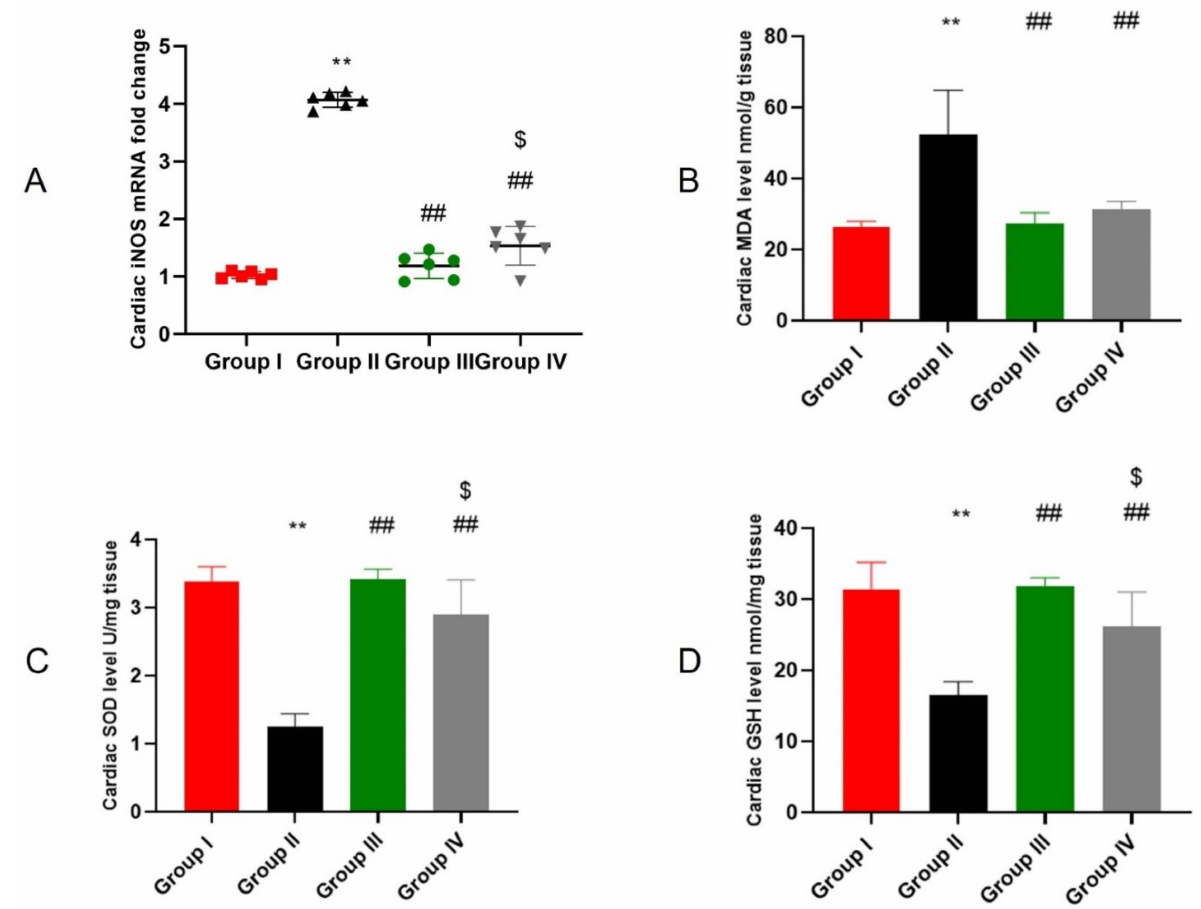
Figure 4. Effect of ADMSCs-derived exosomes on DOX/Trz-induced cardiac oxidative stress: ( A ) Car- diac inducible nitric oxide synthase (iNOS). Data are expressed as median (maximum and minimum); ( B ) Cardiac level of malondialdehyde (MDA); ( C ) Cardiac level of superoxide dismutase (SOD); and ( D ) Cardiac level of reduced glutathione (GSH). Results are expressed as mean ± SEM. **, significant compared to Group I at p < 0.01; ##, significant compared to Group II at p < 0.01; $, significant compared to Group III at p < 0.05; n =